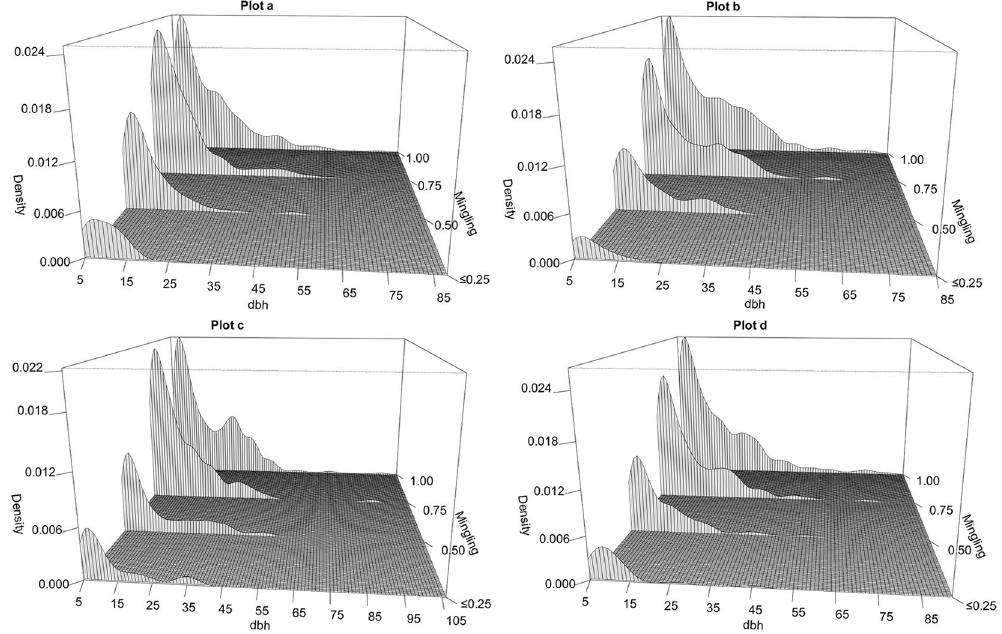
Figure 2. Bivariate distributions of tree sizes and mingling. Tree dbh size is a continuous variable, whereas the associated mingling is a discrete variable assuming one of four values: 0 and 0.25, 0.5, 0.75, or 1. The four nearest-neighbour trees were used to construct the mingling index. Trees with mingling levels of 0 and 0.25 were grouped into a single